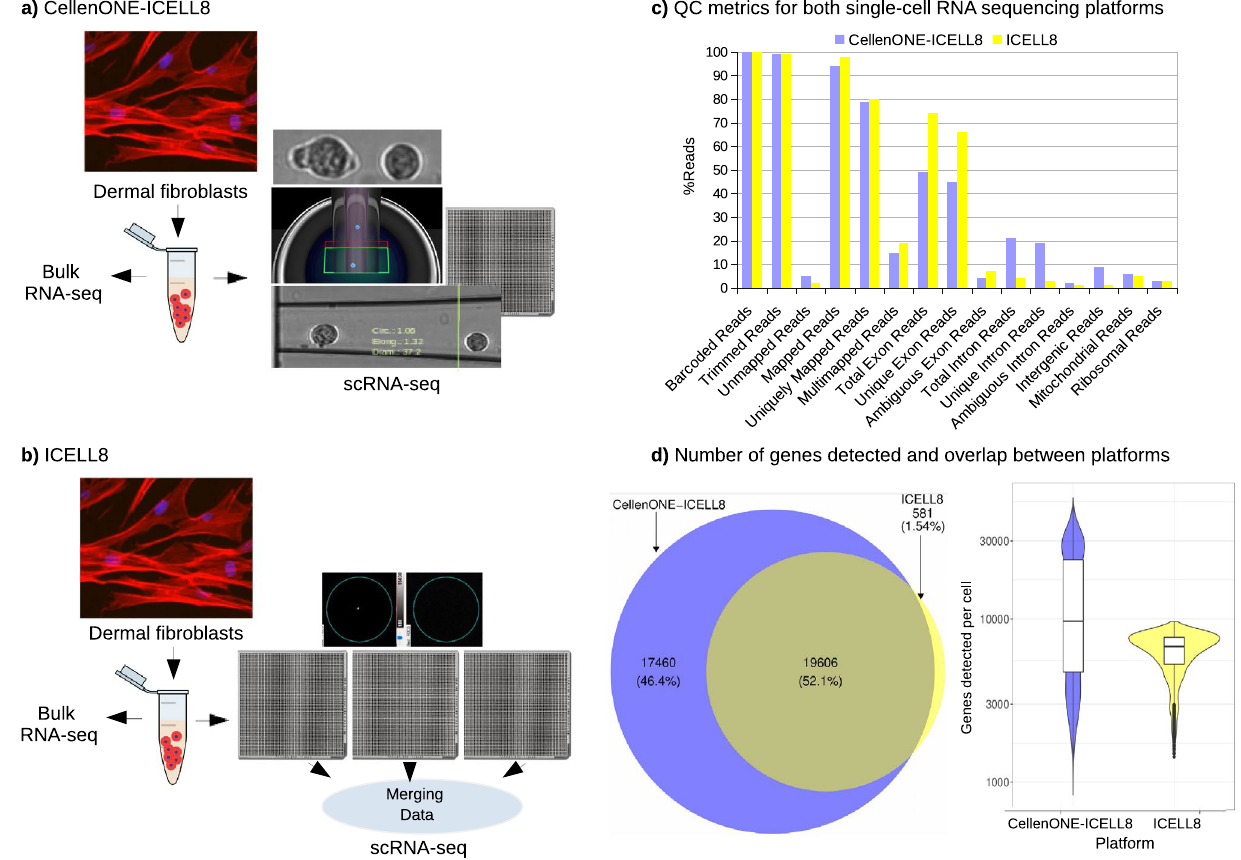
Figure 2. Study design for the scRNA-Seq approaches validation. ( a ) Experimental design for the CellenONE- ICELL8 Single-Cell System combination. Only one ICELL8 nano-well chip was used for all eight dermal fibroblasts patient samples. ( b ) Experimental design for the ICELL8 Single-Cell System. A total of three (3) ICELL8 nano-well chips were used for all eight dermal fibroblasts patient samples. ( c ) Bar plot displaying proportions of reads left in both single-cell methods after each step of the analysis. ( d ) Venn diagram displaying the number of genes in QC-filtered data from both approaches and the violin plot shows the number of QC-filtered genes expressed in individual cells in both